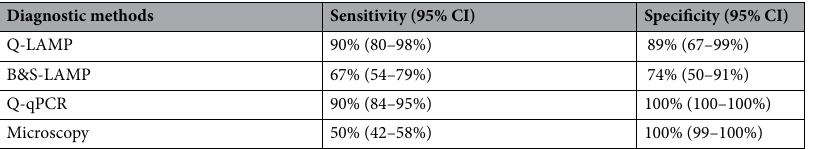
Table 4. Estimated sensitivity and specificity of the diagnostic tests for LD bodies in 76 probable PKDL patients, under a Bayesian latent class modeling